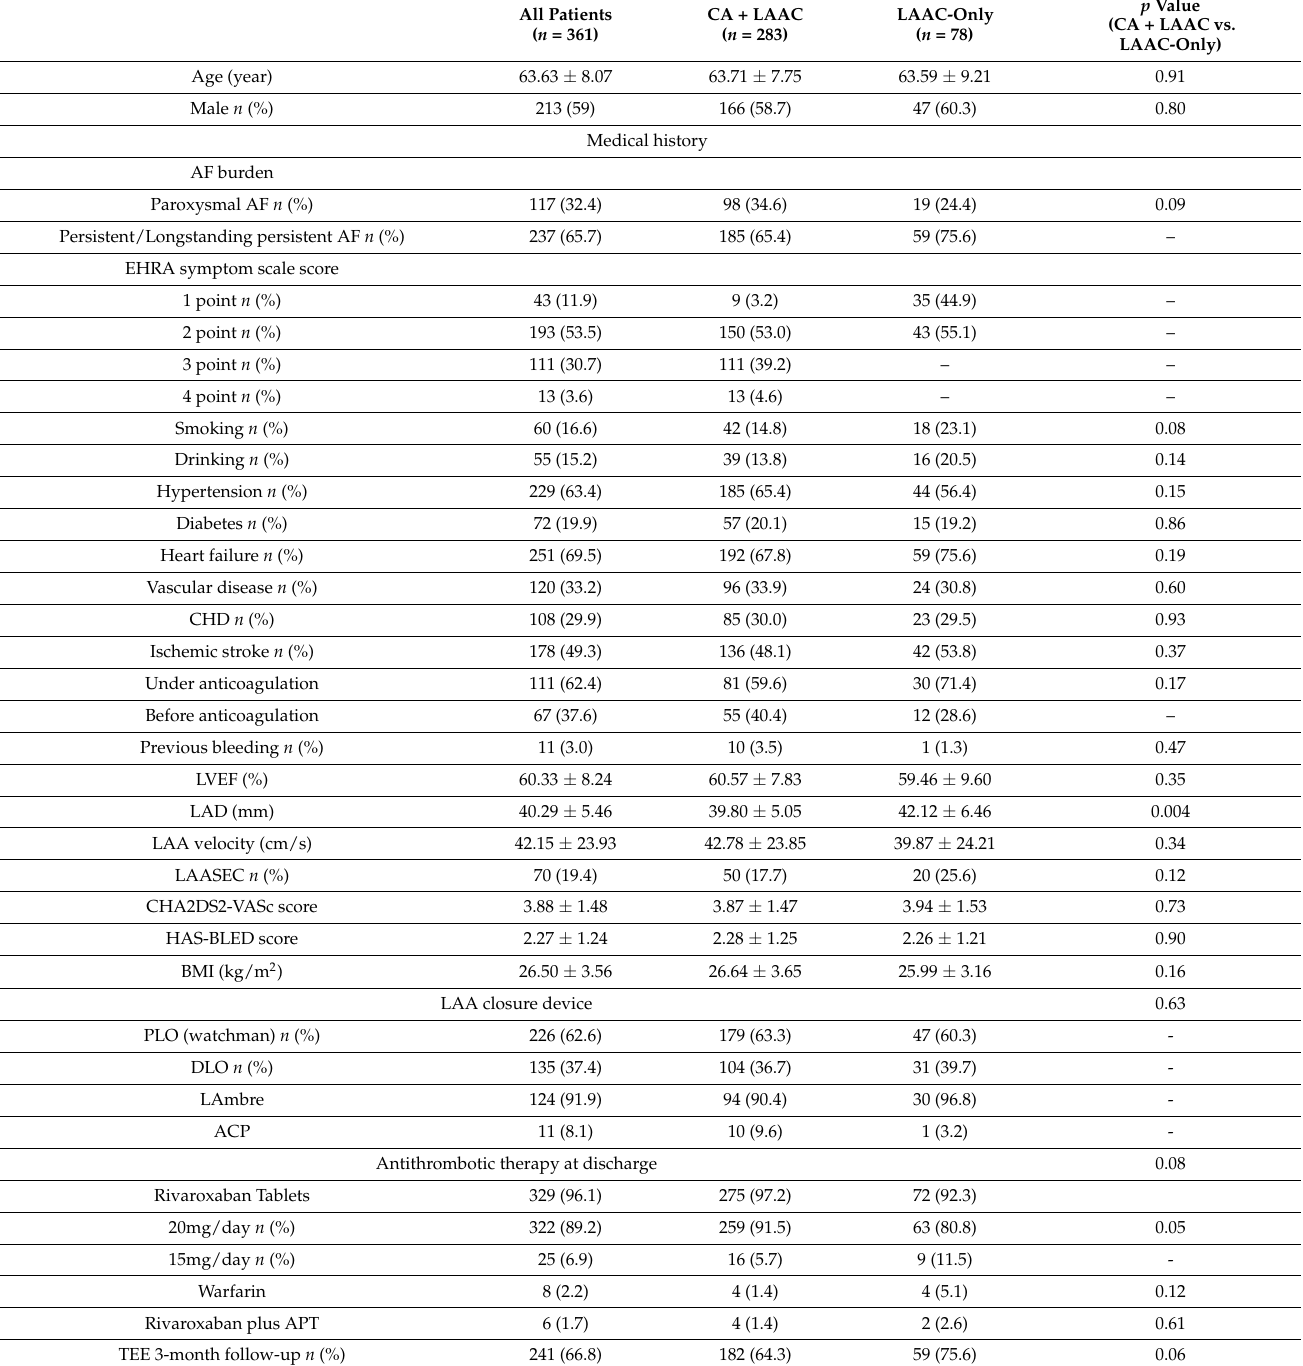
Table 1. Baseline Characteristics of the Study